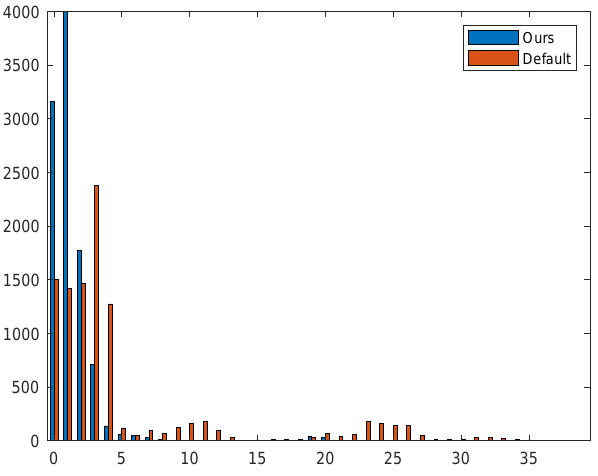
Figure 10. The comparison of jitter distribution.